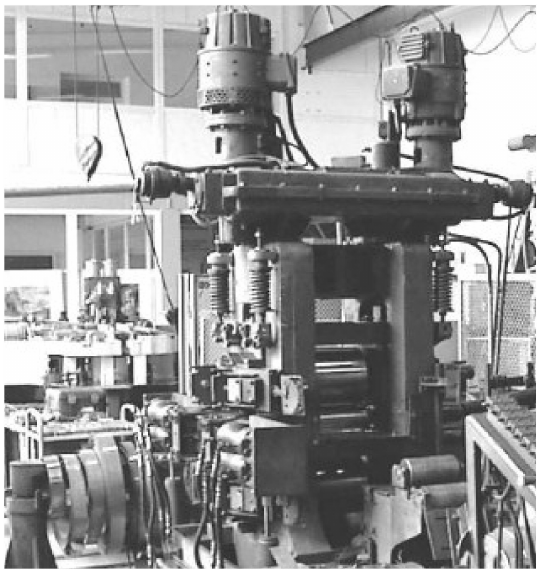
Figure 2. Industrial and laboratory rolling duo-mill, 260 × 200,